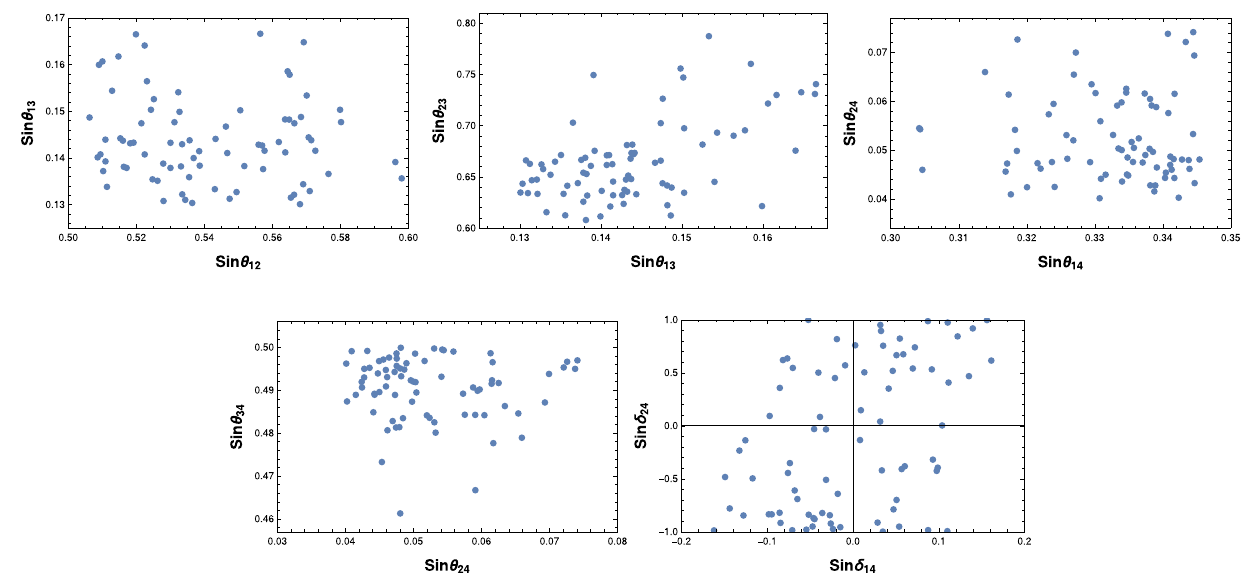
Fig. 4 Neutrino oscillation parameters in active-sterile sector for case (ix) from texture 1 zero category for